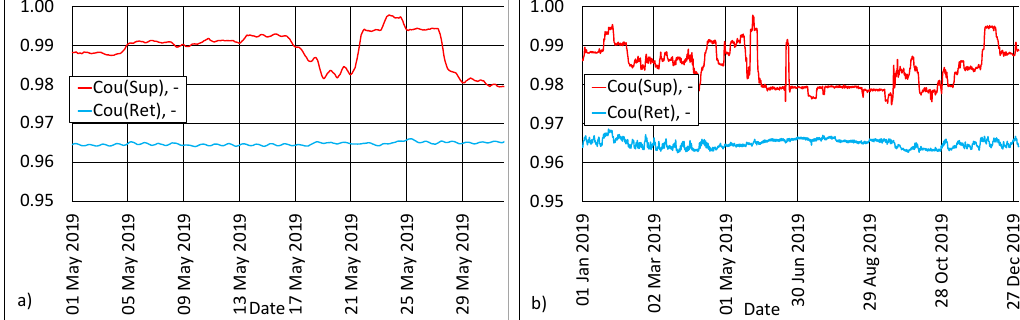
Figure 7. Changes in Courant number values in the supply Cou(Sup) and return Cou(Ret) pipeline during the calculation for data in May 2019 ( a ), and the whole year of 2019 ( b ).